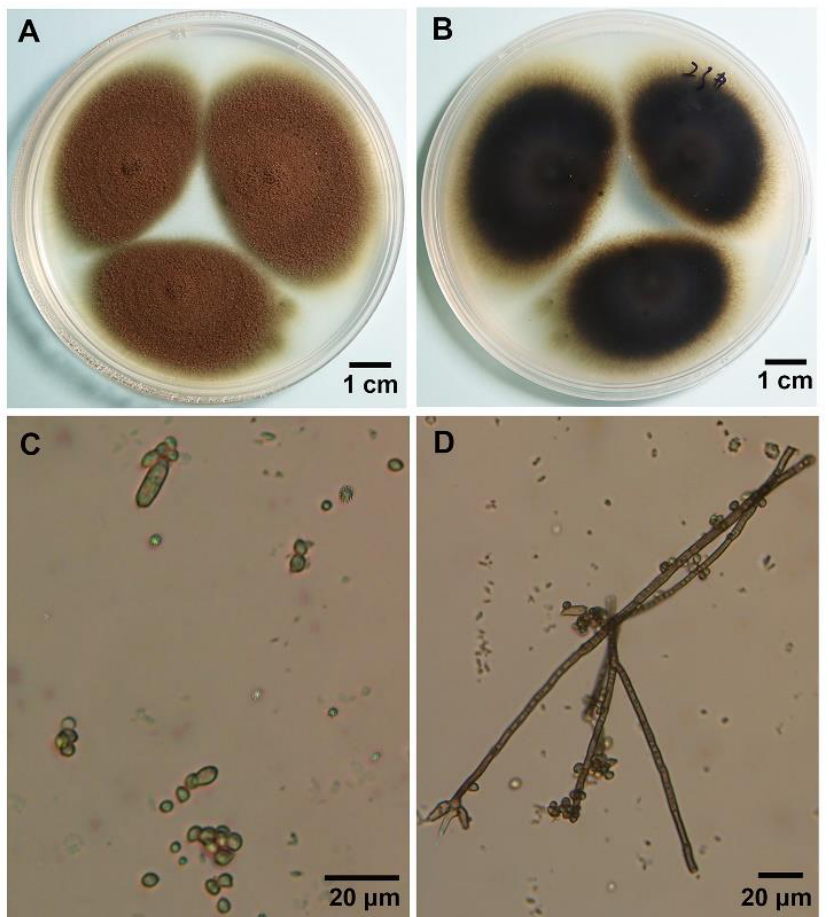
Figure 2. Morphological characteristics of the Cladosporium cladosporioides isolate under a light microscope. ( A , B ), C. cladosporioides cultured on PDA medium at 25 °C for 9 days, the front side and the reverse side, respectively. ( C , D ), Septate hyphae and conidia.